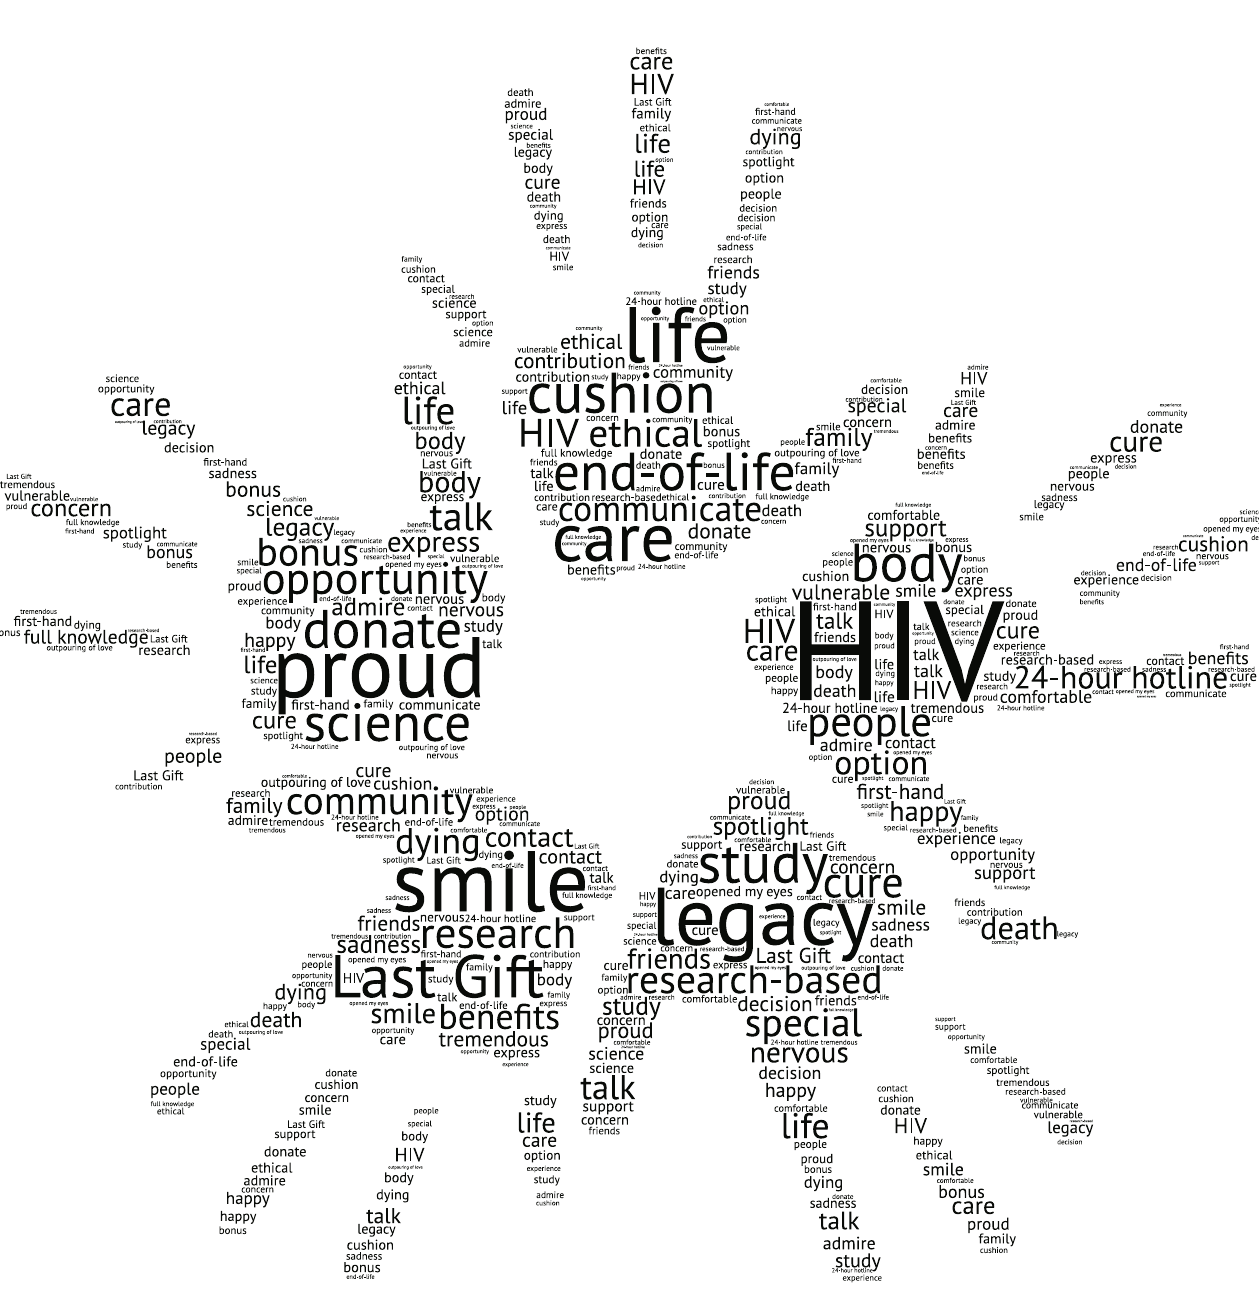
PLOS ONE | https://doi.org/10.1371/journal.pone.0250882 May 7,